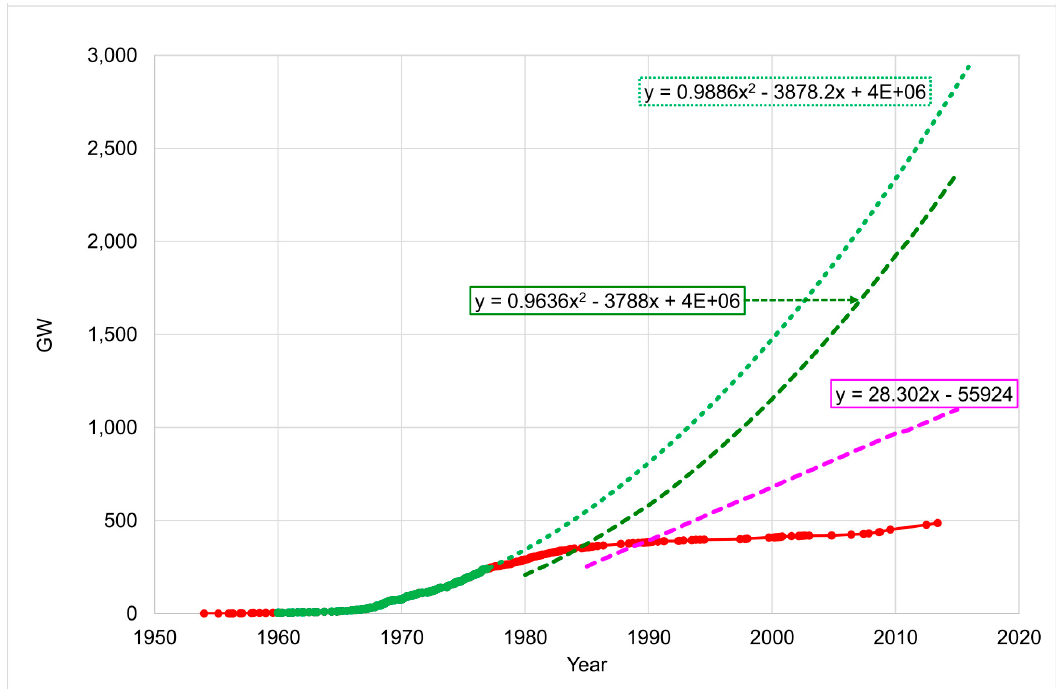
Figure 6. ( Top ) Cumulative global capacity of construction starts and of commercial operation starts (sorted by construction start date); ( Bottom ) Cumulative global capacity of construction starts (red and green data points); accelerating projection of 1960–1976 data points (dotted green line); Linear and Accelerating projections of capacity in commercial operation (dashed pink and green lines).